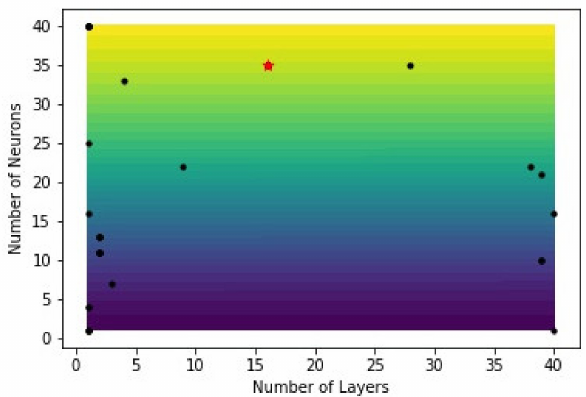
Figure 3. Optimized Bayesian Neural Network (BNN) number of neurons in each layer plotted with number of layers.